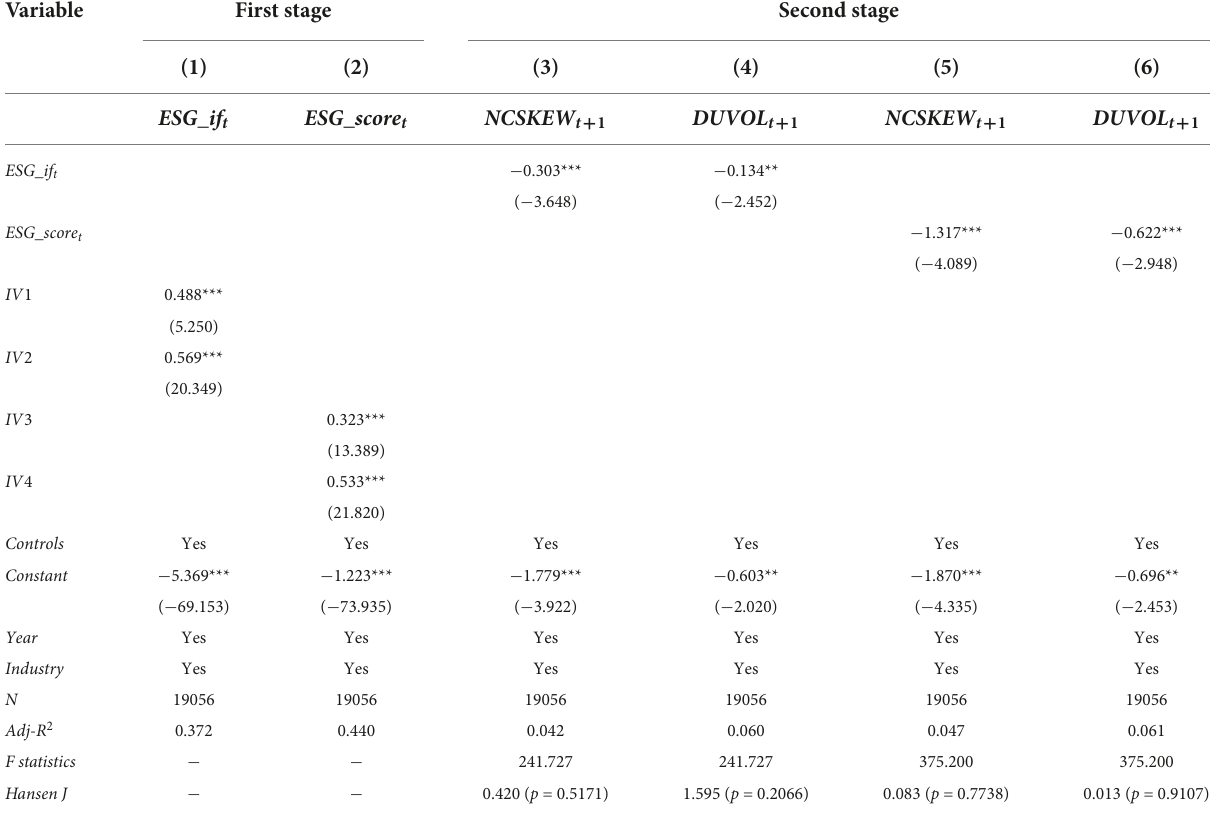
TABLE 4 Instrumental variables